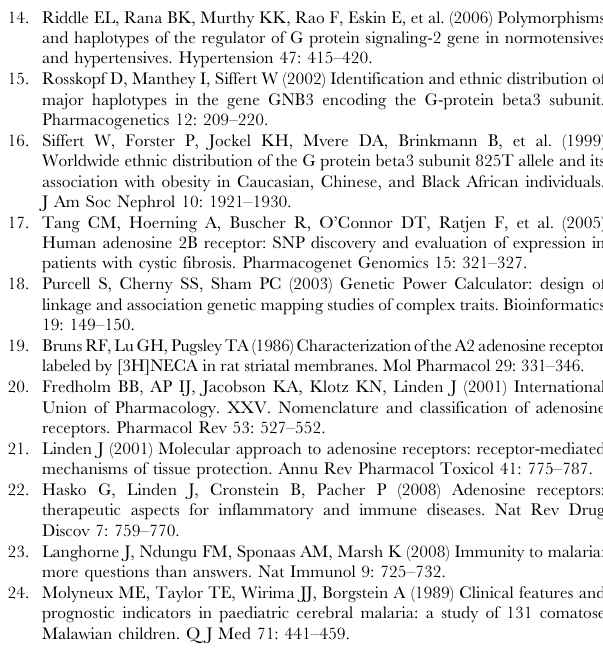
Table S3 Properties of Gs pathway candidates. 1 Region investigated using haplosimilarity (HS) and extended haplotype homozygosity (EHH) tools for detecting signatures of